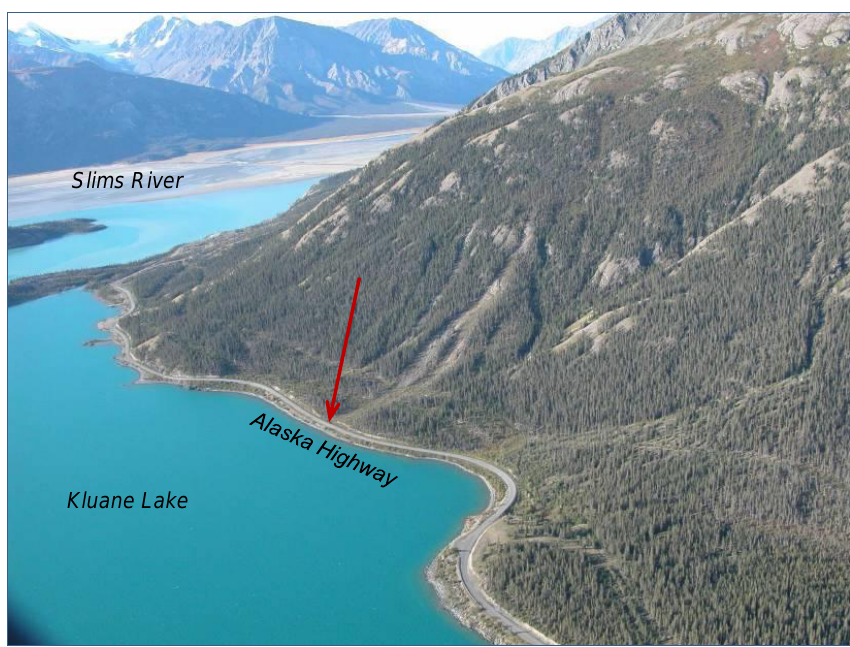
Figure 9. Oblique photo of debris flow channels at Horseshoe Bay, southwestern end of Kluane Lake (photo by C. Huscroft). During the 1988 storm event, debris flow deposits blocked the Alaska Highway (e.g. red arrow) for up to 7 days (Evans and Clague, 1989). (Site F in Figs. 7 and